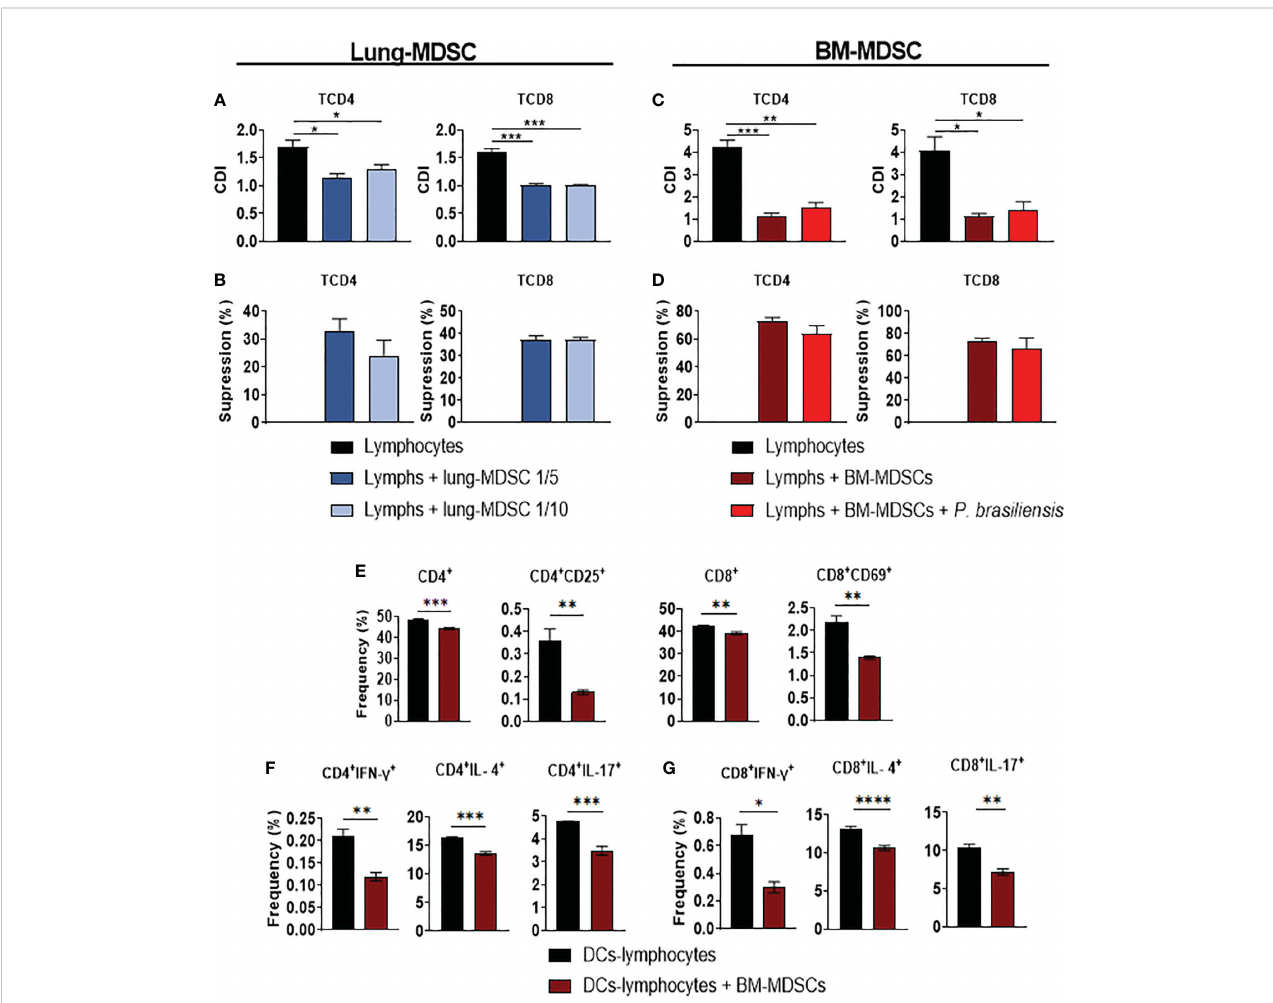
FIGURE 4 Suppression of T-cell responses by MDSCs. To evaluate the ability of MDSCs to suppress T cell proliferation, MDSCs were obtained from the lungs of P. brasiliensis- infected mice after two weeks of infection (Lung-MDSCs). Alternatively, bone marrow-derived MDSCs (BM-MDSCs) were generated in vitro and challenged overnight or not by P. brasiliensis at a ratio of 1:50 (yeast: MDSCs), as indicated in the material and methods. Both Lung-MDSCs (A, B) and BM-MDSCs (C, D) were sorted and subsequently cocultured with CFSE-labeled CD3 + T cells, previously activated with anti-CD3/CD28 antibodies. Following coculture for four days (ratios of 1:10 and 1:5 -MDSC: lymphocytes- for L-MDSCs and ratio of 1:10 for BM-MDSCs), the proliferation of the CD4 and CD8 T cells was characterized by fl ow cytometric analysis, and the cell division index (CDI) was obtained (A, C) . To better evaluate the ability of Lung-MDSCs (B) and BM-MDSCs (D) to suppress lymphoproliferation, the percentage of T cell suppression was calculated from CDI results. To evaluate the ability of BM-MDSCs to suppress activated T cells (E) and Th/Tc lymphocytes differentiation (F, G) , spleen lymphocytes from naïve mice were cocultured with BM-DCs that were previously challenged with P. brasiliensis yeasts (ratio 1:50; yeast-DCs). After 24 hours of DC-Lymphocyte coculture, the BM-MDSCs were added to the coculture (ratio of 1:10; MDSC: T cells) and T cell responses were compared to cocultures without MDSCs. After four days of coculture, lymphocytes were evaluated by fl ow cytometry for total and activated T cells (CD4 + , CD4 + CD25 + , CD8 + and CD8 + CD69 + ) (E) , and for intracellular expression of Th-signature cytokines by CD4+ T cells (Th1: CD4 + IFN- g + ; Th2: CD4 + IL-4 + , Th17: CD4 + IL-17 + ) (F) , and CD8+ T signature cytokines (Tc1: CD8 + IFN- g + , Tc2: CD8 + IL-4 + , Tc17: CD8 + IL-17 + (G) . Data represent two independent experiments. For comparisons between two groups, the mean ± SEM was obtained and analyzed by the unpaired Student ’ s t -test. Differences were considered signi fi cant when: * p <0.05; ** p <0.01; *** p <0.001 and **** p